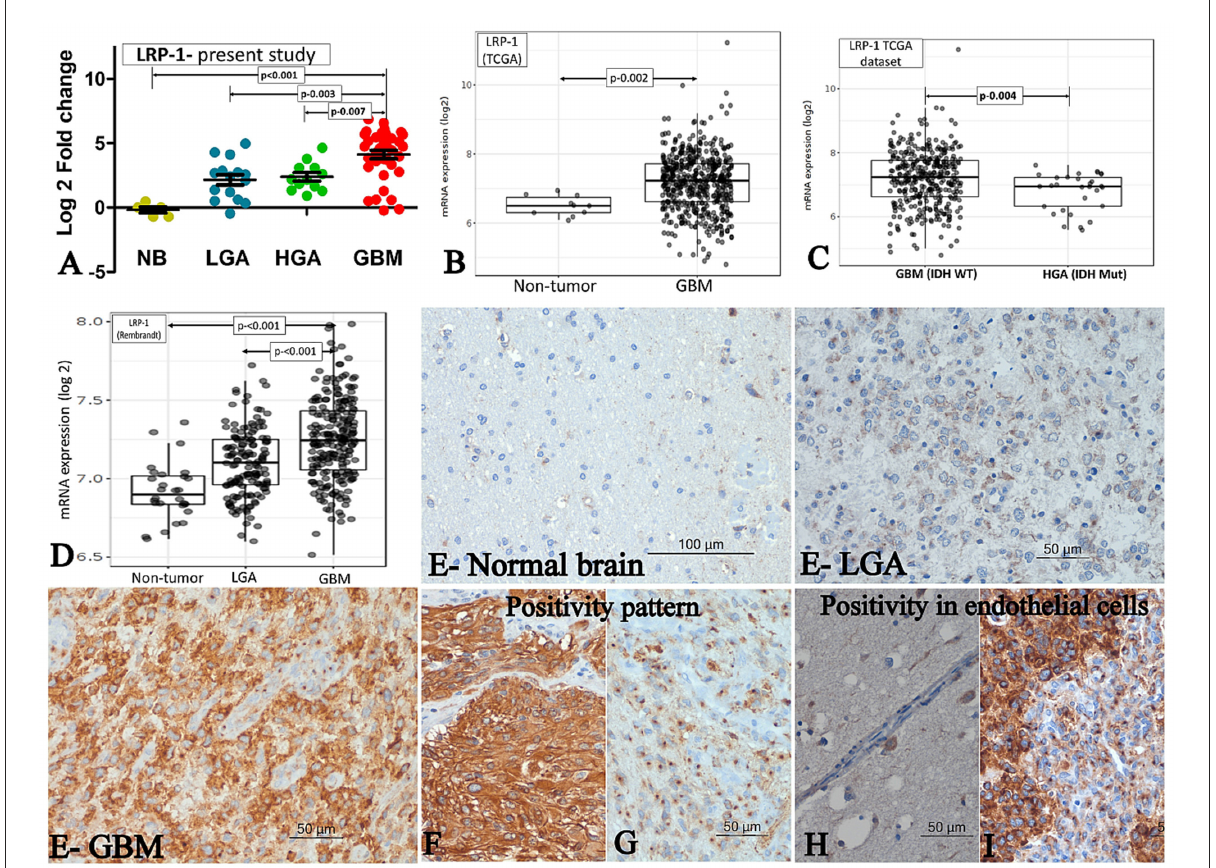
FIGURE1 LRP-1 expression. (A–D) mRNA expression. The mRNA expression of LRP-1 in cases of GBM and its comparison with IDH mutant lower grade astrocytic tumors (LGA)/ higher grade astrocytic tumors (HGA) in the present study (A) , TCGA dataset [normal brain (NB) vs. GBM] (B) , TCGA dataset [GBM, IDH wild type vs. Astrocytoma, IDH mutant, grade 4] (C) and Rembrandt dataset (D) . [Mann-Whitney U test was used to ascertain the p -value depicted in the photographs. The parameters compared are denoted by ( ⇄ ) sign]. (E–I) Immunohistochemistry. LRP-1 immunohistochemistry in normal and tumor samples (E) . There was no expression in normal brain (E-normal brain), low expression in LGA (E-LGA) and high expression in GBM (E-GBM). The pattern of expression in tumor cells - Cytoplasmic with membranous (F) and